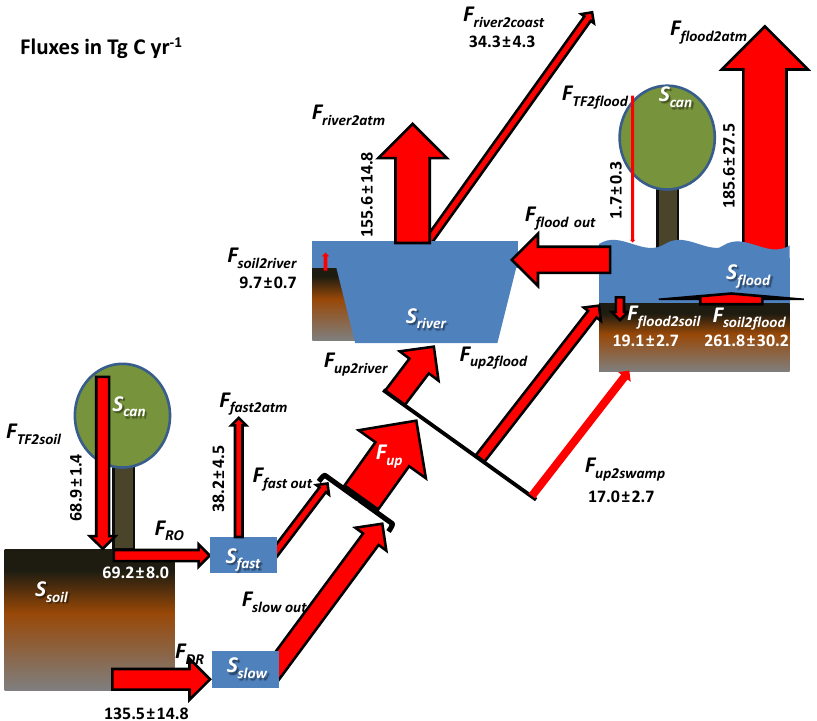
Figure 19. Simulated fluxes of dissolved carbon (DOC + CO 2 ) through the inland water network of the Amazon basin. Numbers are average annual fluxes ± standard deviations over the simulation period